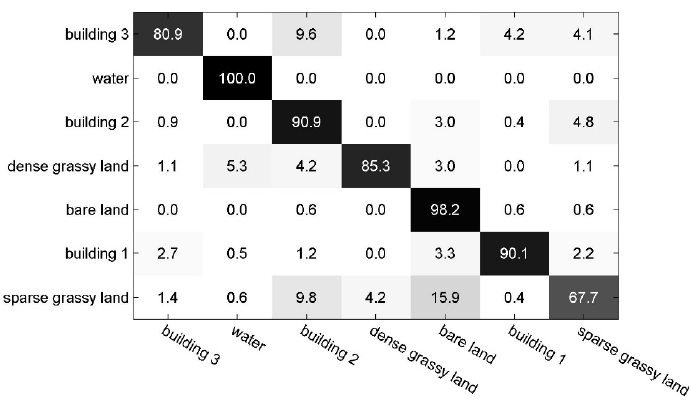
Figure 11. Confusion matrix for the classification results based on the CTS descriptor on